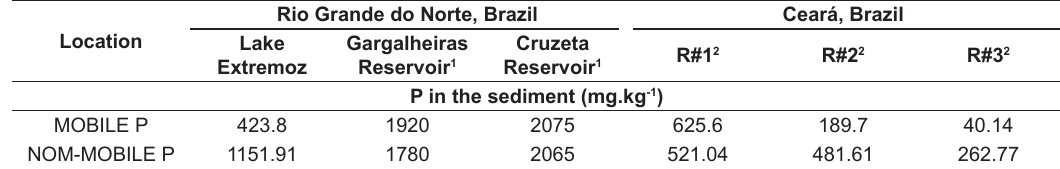
Table 2. Literature data of P in the sediment of freshwater bodies in the northeast of Brazil.